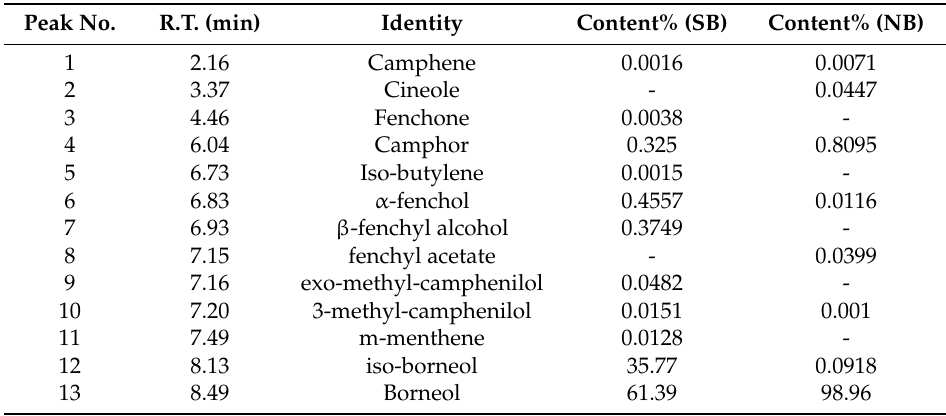
Table 1. Characterization of components in synthetic borneol (SB) and natural borneol (NB) by gas chromatography-mass spectrometer (GC-MS). Peak No.